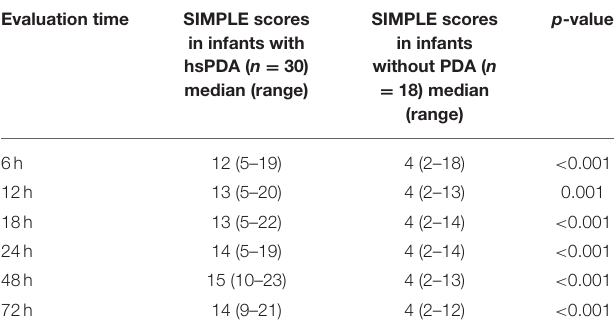
TABLE 6 | SIMPLE scores in infants with/without hemodynamically significant patent ductus arteriosus (hsPDA) by echocardiography. Evaluation